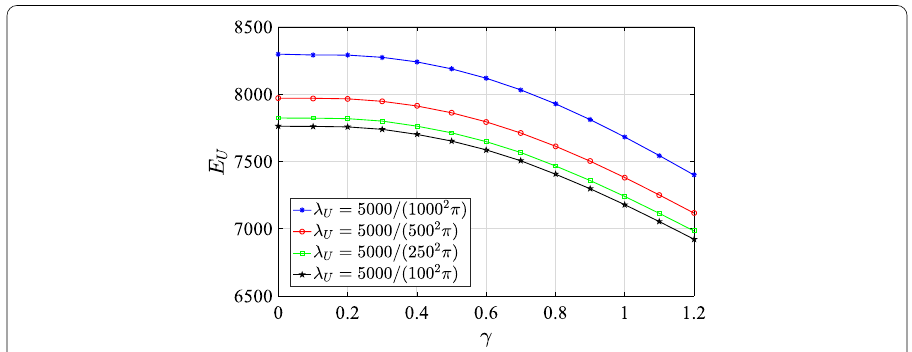
Fig. 5 The effect of γ on E U under different (cid:31)